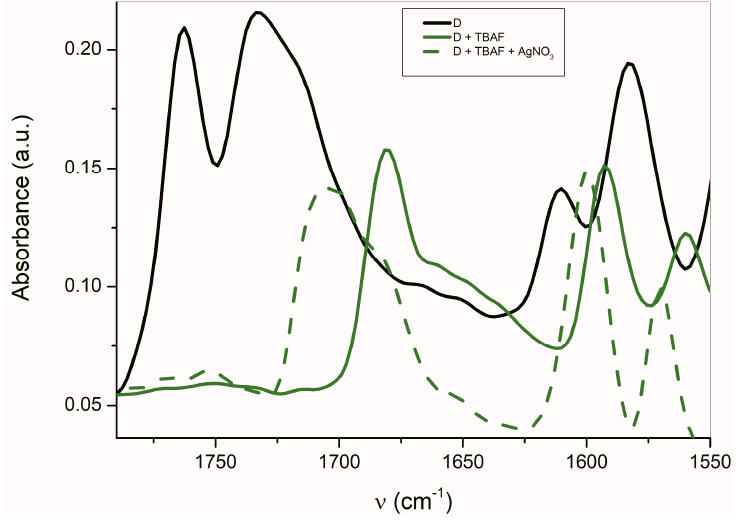
Figure 8. FTIR spectra of D in the presence of TBA + and Ag + (ATR spectra).